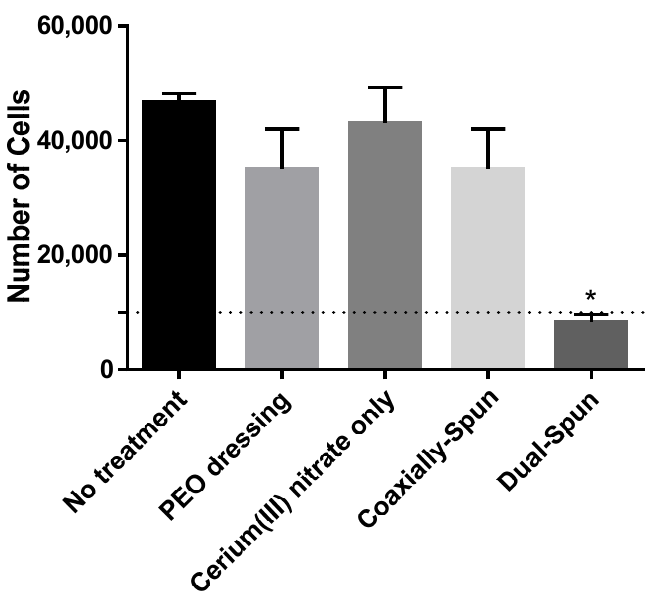
Figure 6. Cell proliferation of human dermal fibroblasts over 72 h (n = 3). Dashed line indicates the original seeding density. * denotes a statistically significant difference ( p < 0.05).